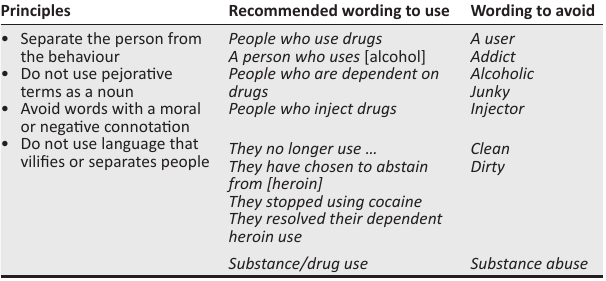
TABLE 6: The use of non-stigmatising language to enhance patient outcomes. 40 †